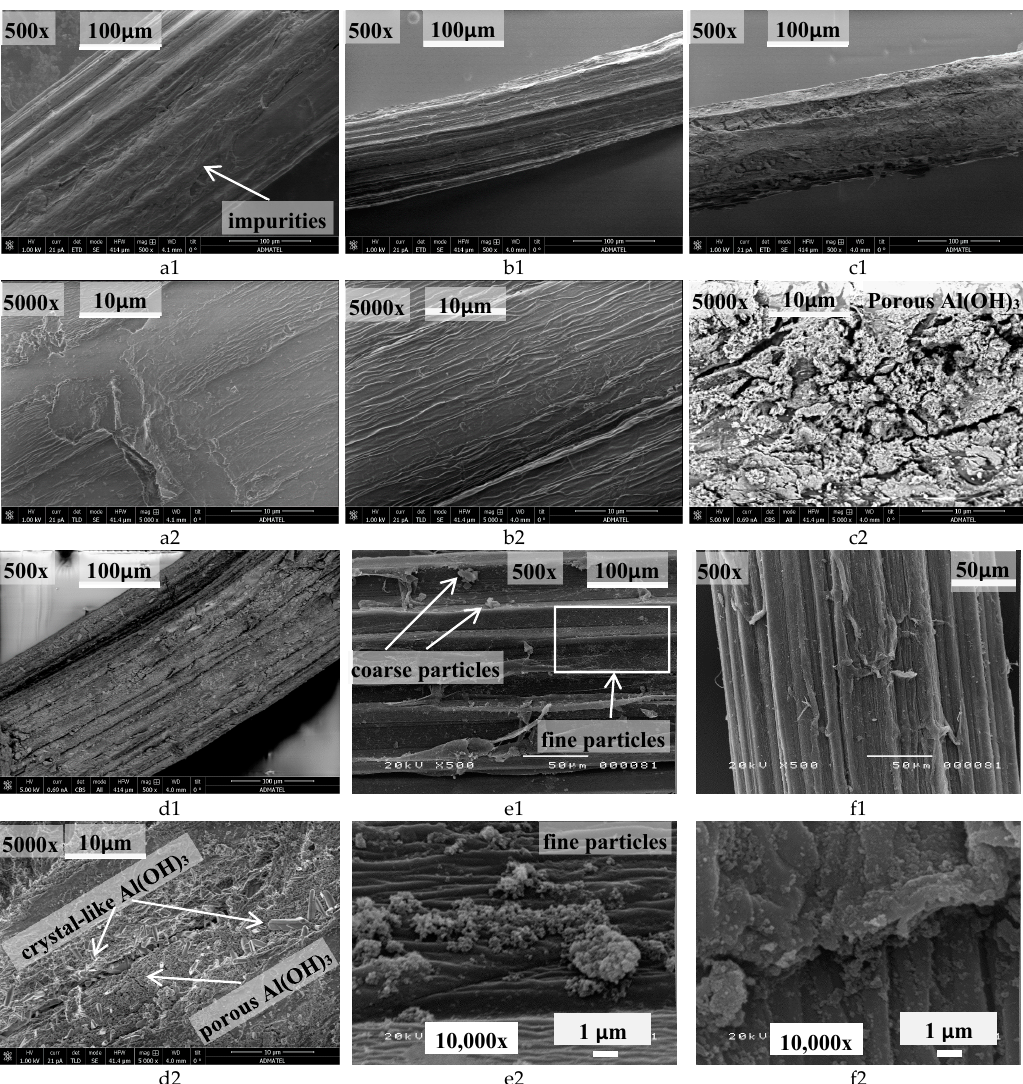
Figure 9. Scanning electron microscopy (SEM) images at low and high magnification of raw (untreated), NaOH-treated and Al 2 (SO 4 ) 3 -treated abaca fibers: ( a ) raw (untreated); ( b ) NaOH treated; ( c ) without NaOH pretreatment; 12 h soaking; final pH = 6; ( d ) with NaOH pretreatment; 12 h; pH = 6; ( e ) without NaOH pretreatment; 12 h; pH = 4.5; and ( f ) with NaOH pretreatment; 0.5 h, pH = 6. Low and high magnification are labeled as “1” and “2”, respectively.